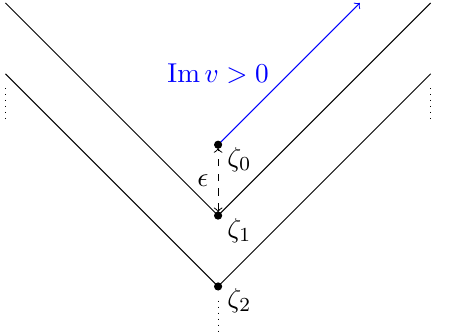
Figure 5. Relationships between the imaginary parts (cid:16) k . A deformation of v in the positive imaginary direction is shown in